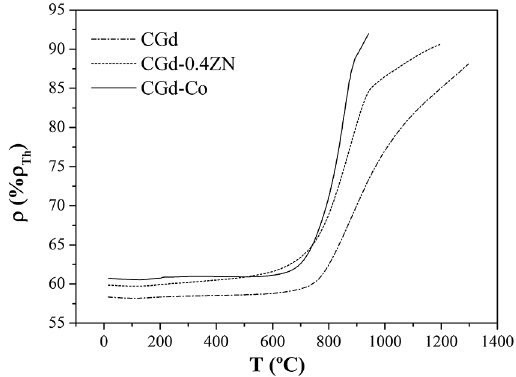
) as function of th